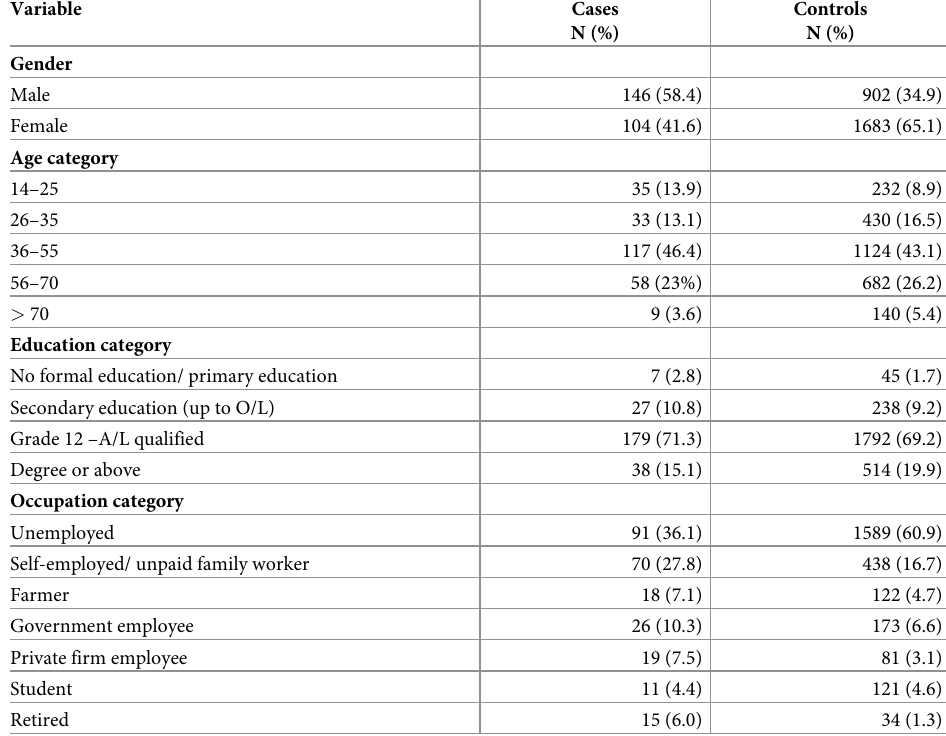
Table 1. Socio-Demographic Characteristics of the study